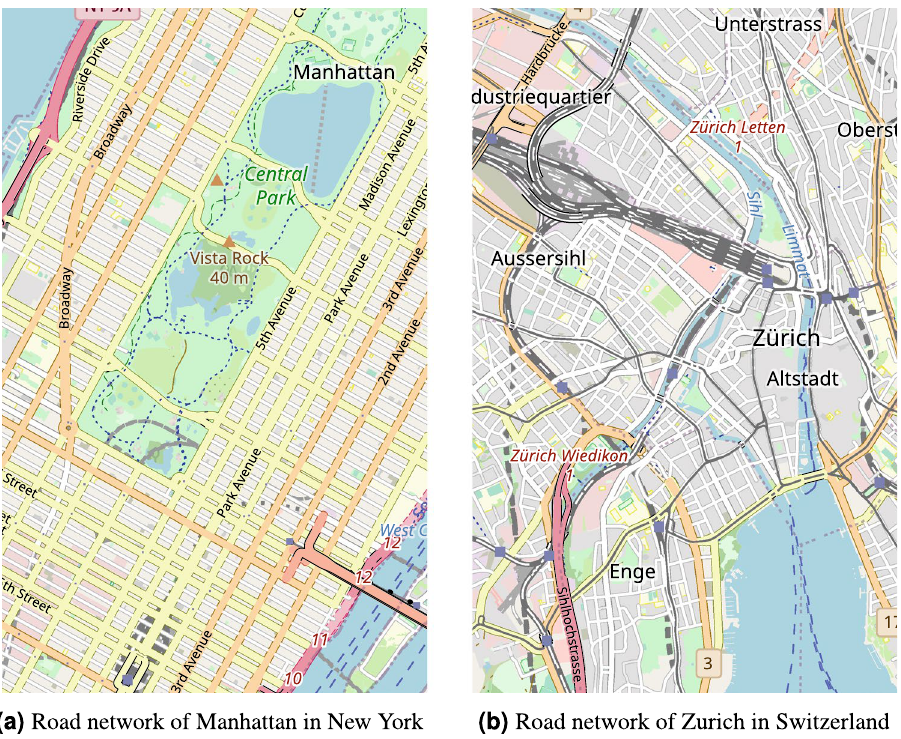
Figure 1. A comparison of the road networks of two large cities, note the difference between the grid like structure of Manhattan and the more chaotic network of Zurich 16